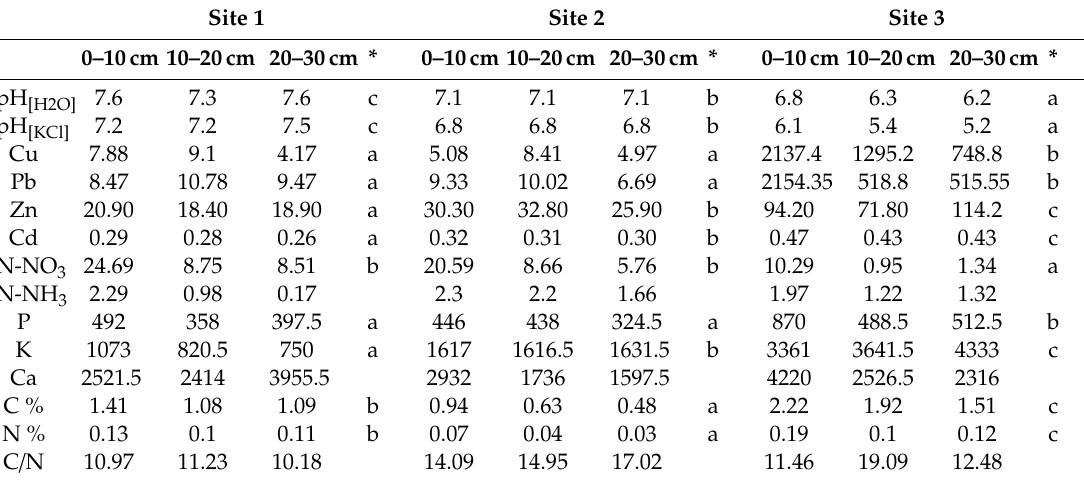
Table 1. Soil chemical characteristics of three sites (parts per